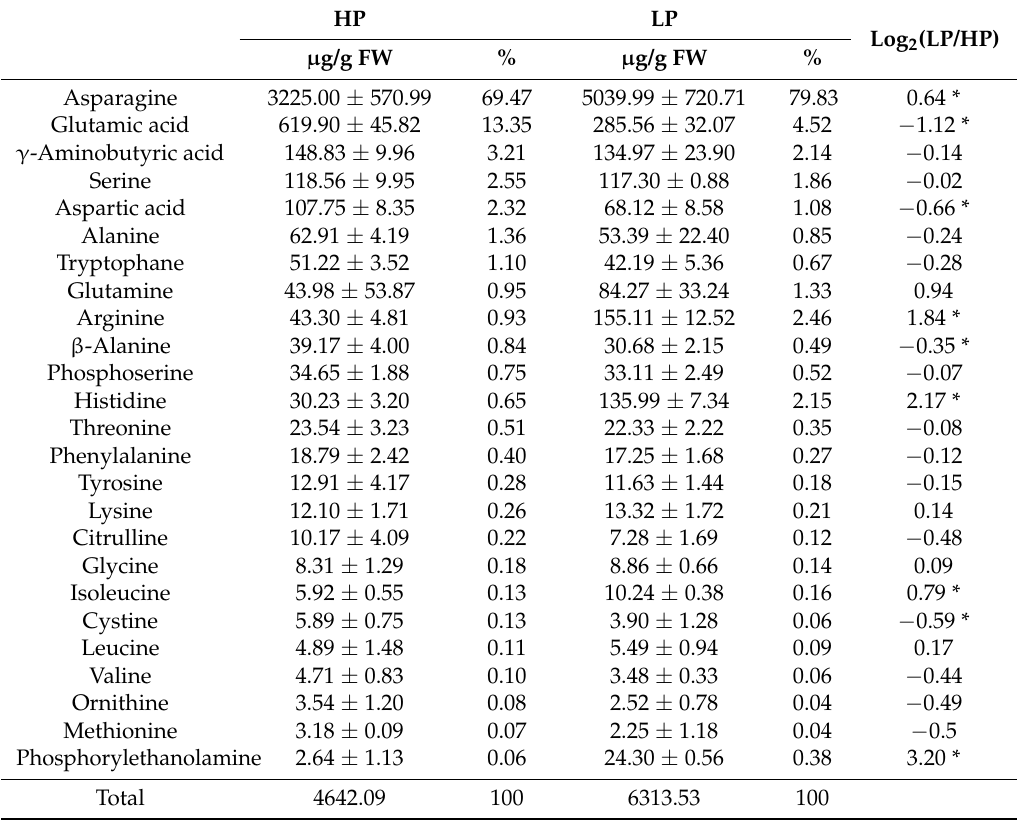
Table 1. Amino acid composition in soybean nodules under phosphate (Pi) sufficient (HP, 500 µ